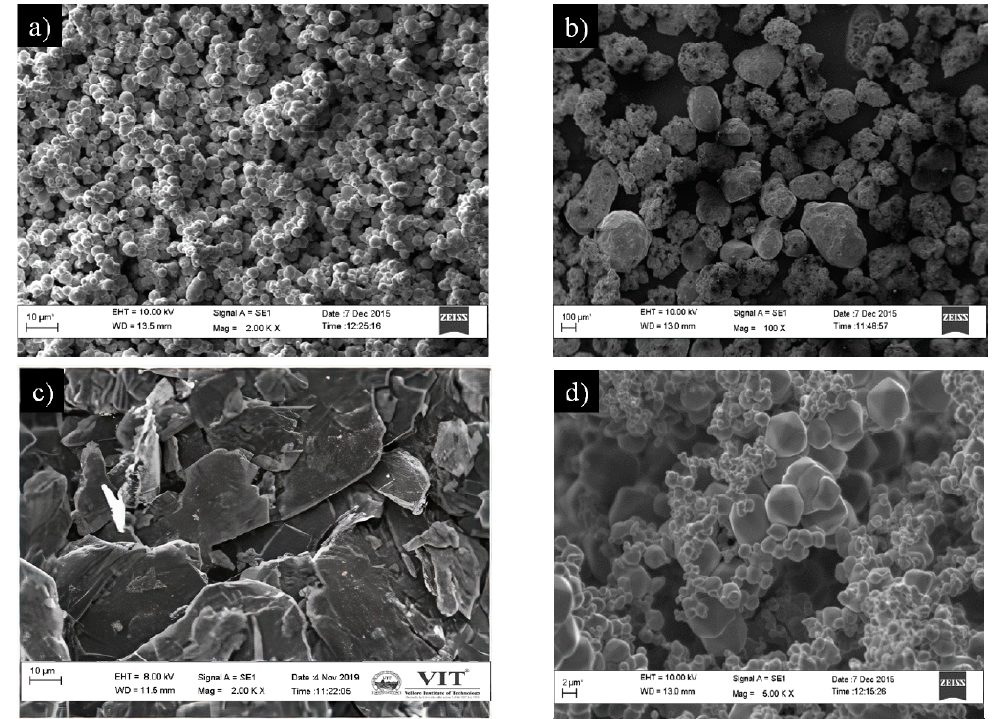
Figure 1. Scanning electron microscope images of as-received powders ( a ) Carbonyl Fe, ( b ) Copper Powder, ( c ) Graphite powder, ( d ) Molybdenum powder.